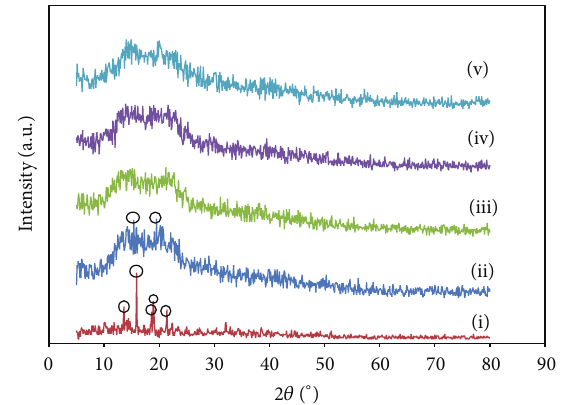
Figure 8: XRD pattern of (i) pure LiTFSI, (ii) pure P(VP-co-VAc), (iii) EMIm 0, (iv) EMIm 10, and (v) EMIm